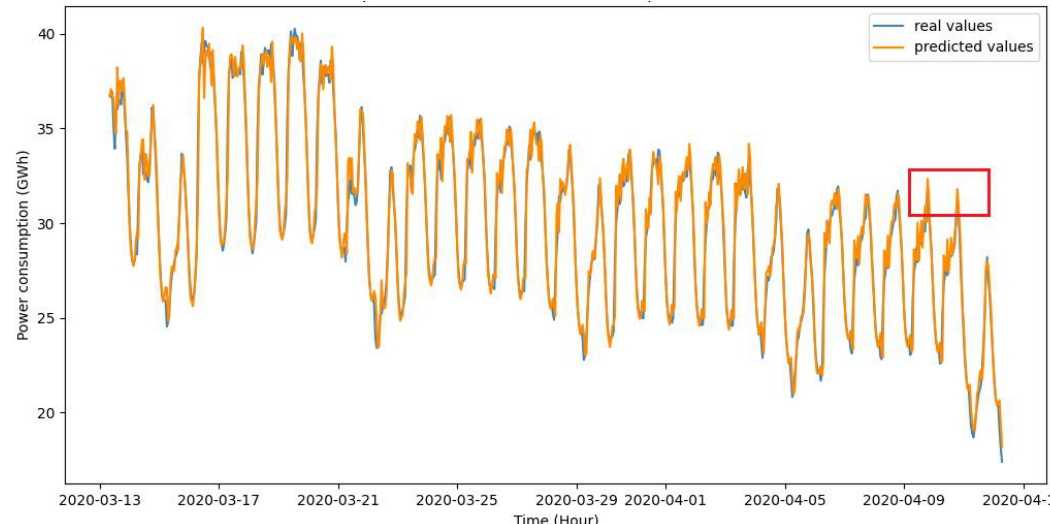
Figure 7. The comparison between the actual values and the predicted values.